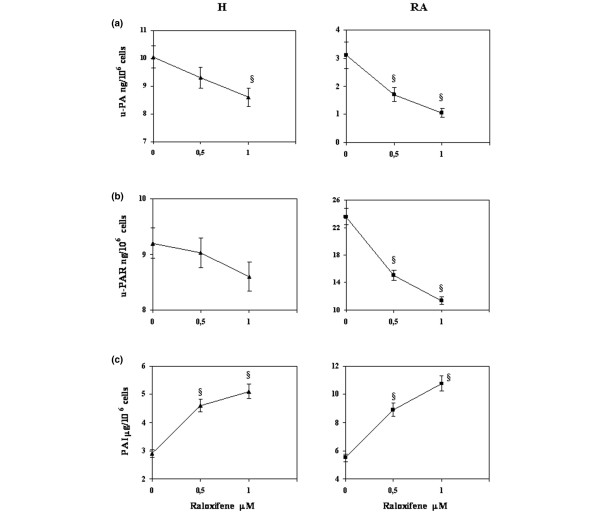
Fibrinolytic pattern of healthy (H) and rheumatoid arthritis (RA) synoviocytes treated with Raloxifene. Samples were analyzed both in basal conditions and after treatment with 0.5 and 1 μM Raloxifene (48 h). (a) Urokinase-type plasminogen activator (u-PA) antigen was quantified on aliquots of the culture medium by ELISA assay and reported as ng/106 synovial cells. (b) u-PA receptor (u-PAR) was quantified by ELISA assay on aliquots of cell lysates and reported as ng/106 synovial cells. (c) Plasminogen activator inhibitor (PAI)-1 was also measured in aliquots of the culture medium, and reported as μg/106 synovial cells. H refers to four different synovial cell cultures from healthy individuals, RA refers to synovial cell cultures from four different rheumatoid arthritis patients. In (a-c), each point represents the mean ± standard deviation of three experiments performed in triplicate on each synovial cell line. § = p < 0.01 versus basal (0.2% FCS).